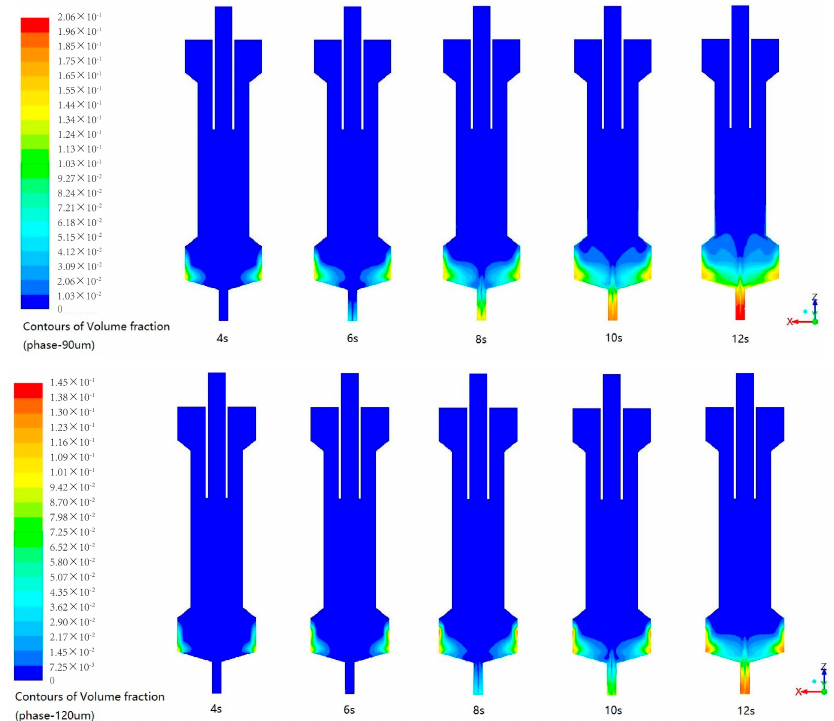
Figure 16. Cloud diagram of the volume fraction change for particles.